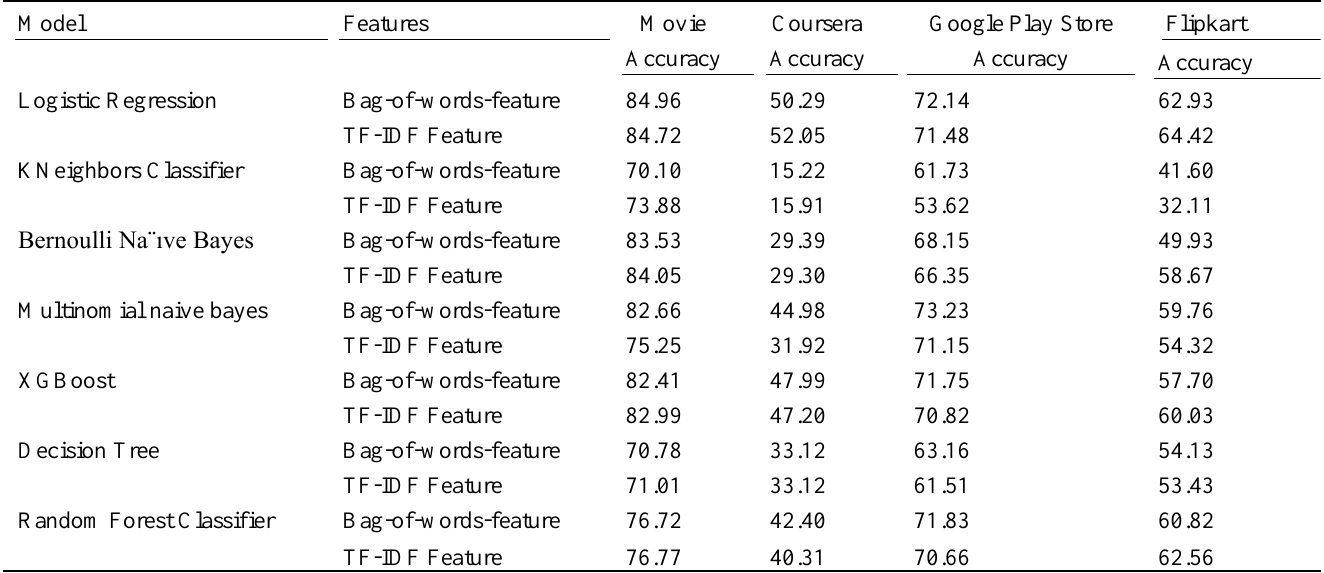
Table 3 Accuracy for various data sets by using machine learning techniques